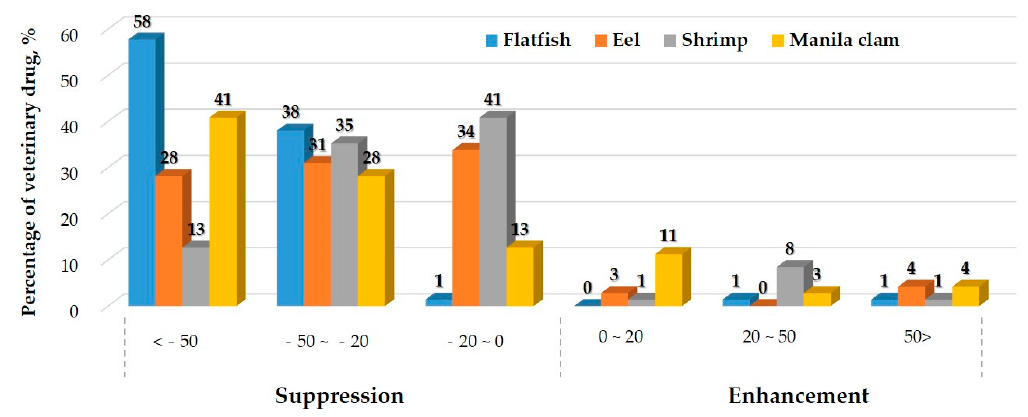
Figure 2. Distribution of matrix effects .